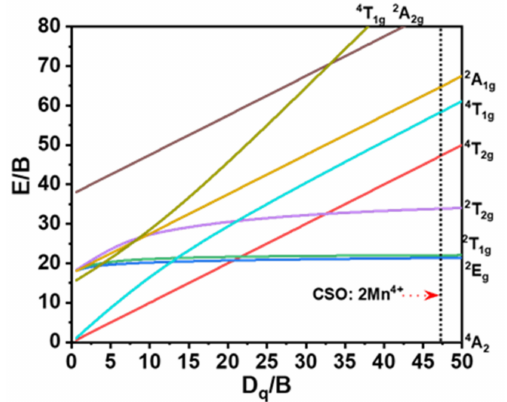
Figure 4. Tanabe-Sugano energy level diagram of Mn 4+.